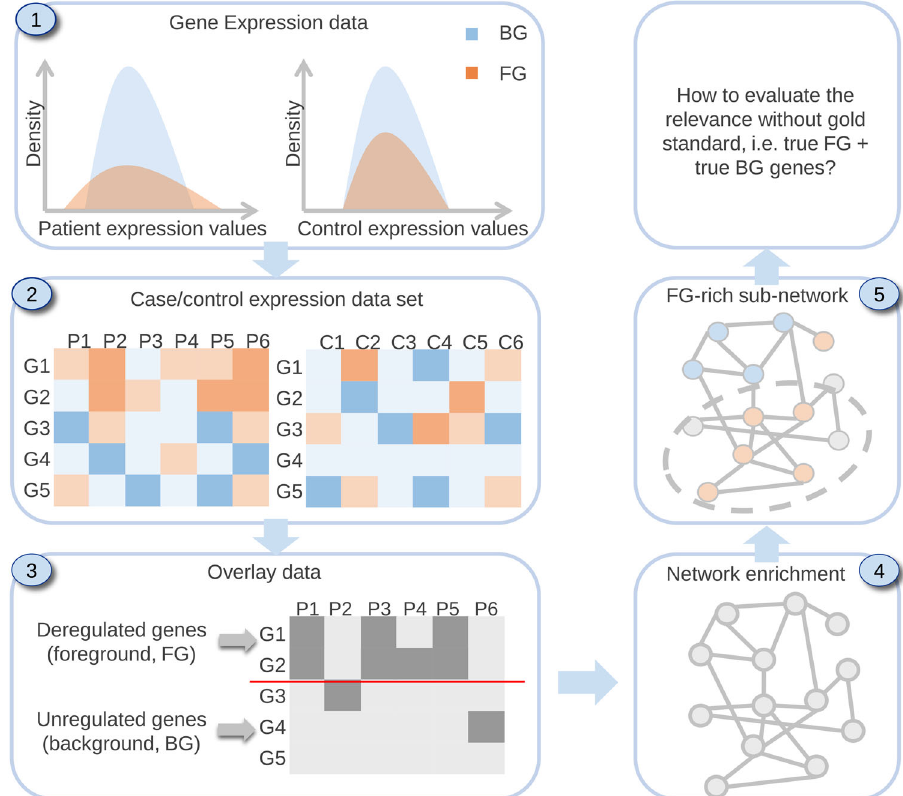
Fig. 1 A typical work fl ow for de novo pathway enrichment. The underlying hypothesis is that phenotype-speci fi c genes (foreground, FG) are differentially expressed in many case samples compared to a control group ( 1 , 2 ) By using statistical tests, one can determine which genes are affected by the phenotype ( 3 ) and overlay this information on an interaction network ( 4 ) De novo pathway enrichment tools aim to extract sub-networks enriched with phenotype-speci fi c FG genes ( 5 ) Comparing several such methods is an open